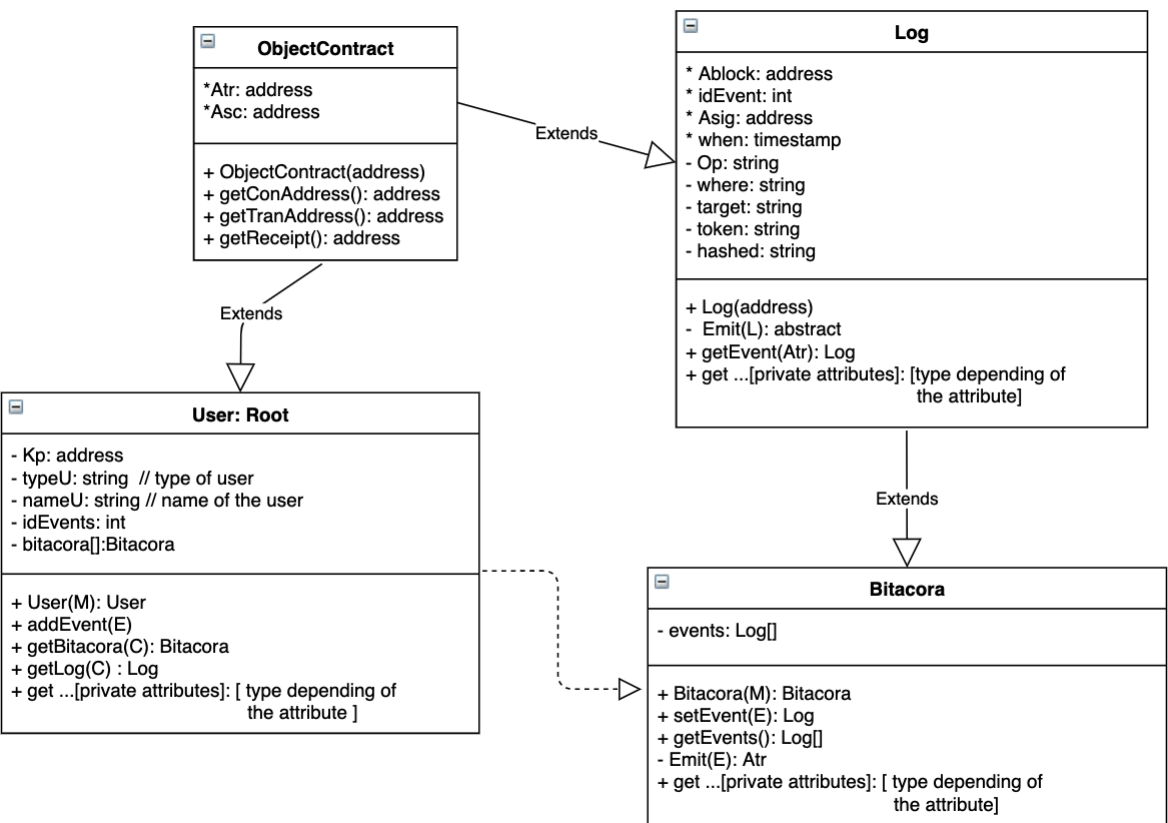
Figure 5. Smart contracts illustrated as class